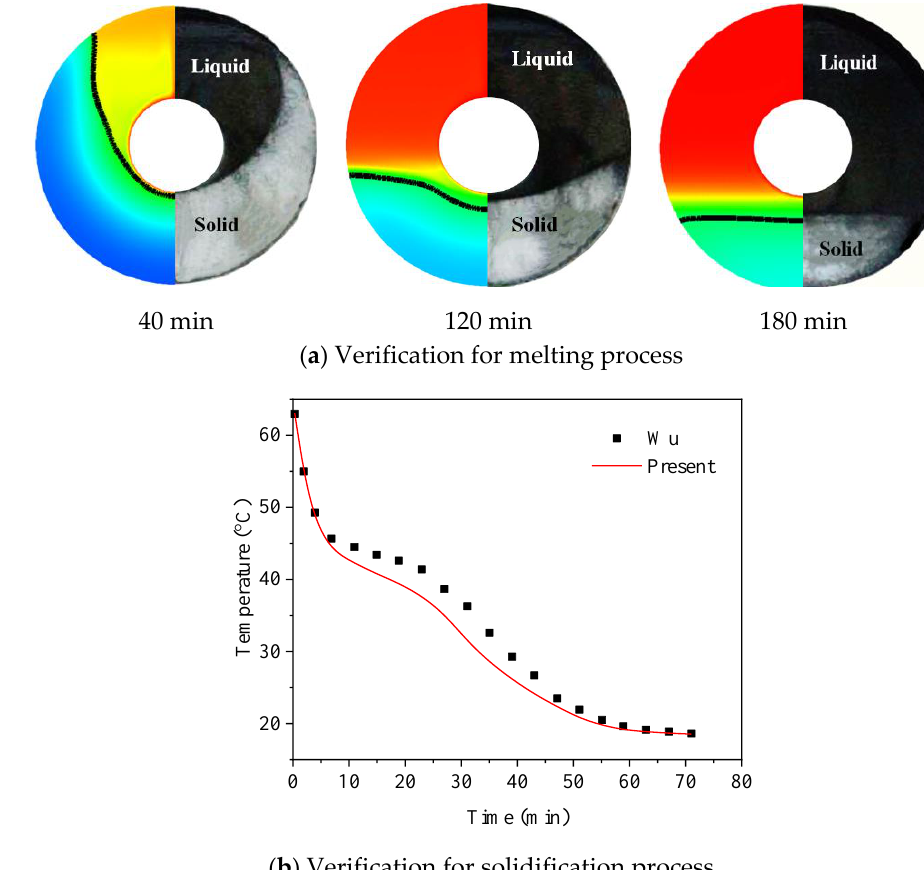
Figure 3. Verification of numerical model.